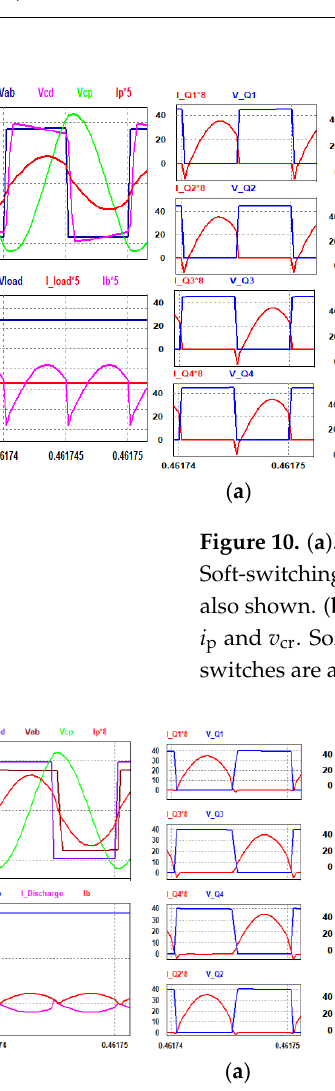
Figure 11. ( a ). Simulation results in reverse mode (RM) with 100% Load at V Battery = 48 V, v ab , v cd , i p and v cr . Soft-switching characteristics for the primary ( Q 1 to Q 4 ) and secondary side ( Q 5 to Q 8 ) switches are also shown. ( b ). Simulation results in RM mode with 10% Load at V Battery = 48 V, v ab , v cd , i p and v cr . Soft-switching characteristics for the primary ( Q 1 to Q 4 ) and secondary side ( Q 5 to Q 8 ) switches are also shown.